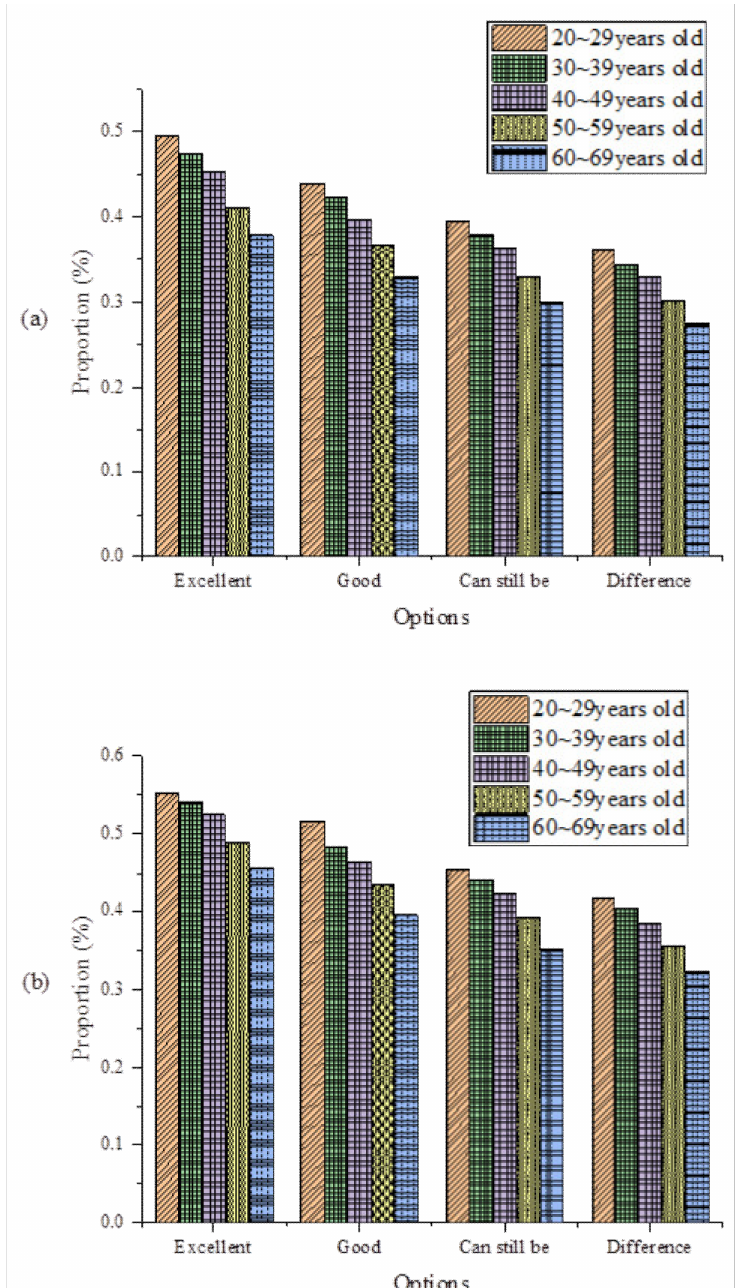
Figure 10. Analysis of cardiopulmonary capacity and cardiovascular health status of workers at different ages in BYD ( a ) before WHSM; ( b ) after